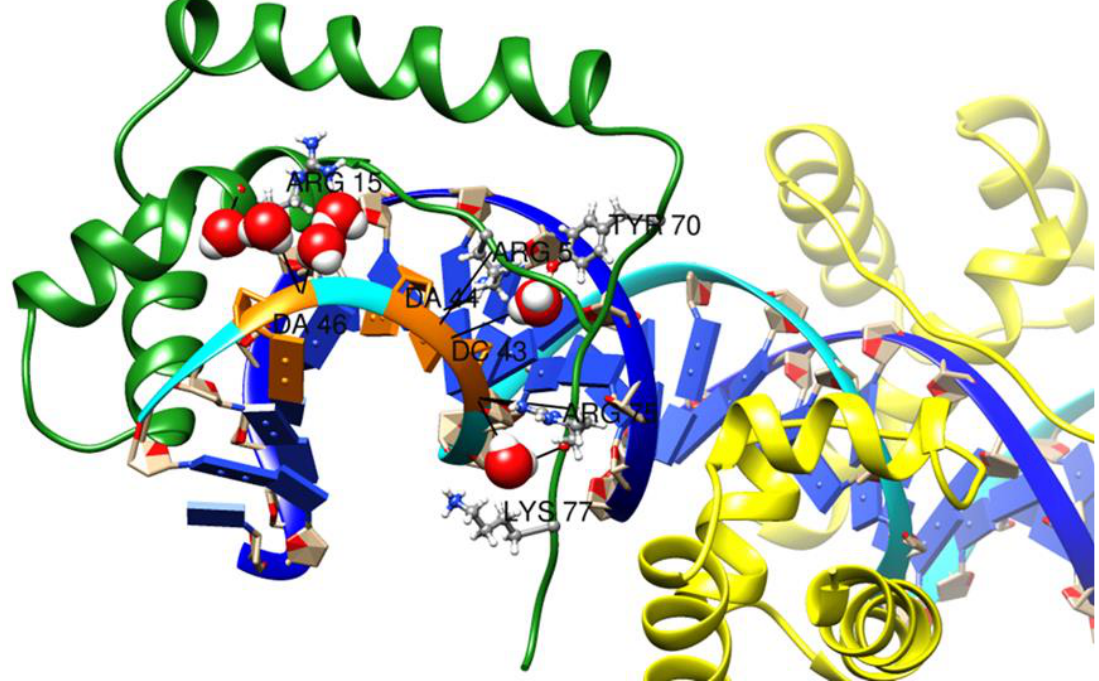
Figure 10. Snapshot taken from the simulation of the SOX2/FGF4/Oct4 complex. SOX2, FGF4, and OCT4 are shown with green, blue, and yellow ribbons, respectively. The interactions between Arg75-C43, Tyr70-DA44, and Arg15-DA46 are mediated by water molecules, which are shown as spheres. All water molecules within a 2.5 Å radius of the N- and C-termini of SOX2 were considered but are not shown for clarity. Hydrogen bonds are denoted by black lines.